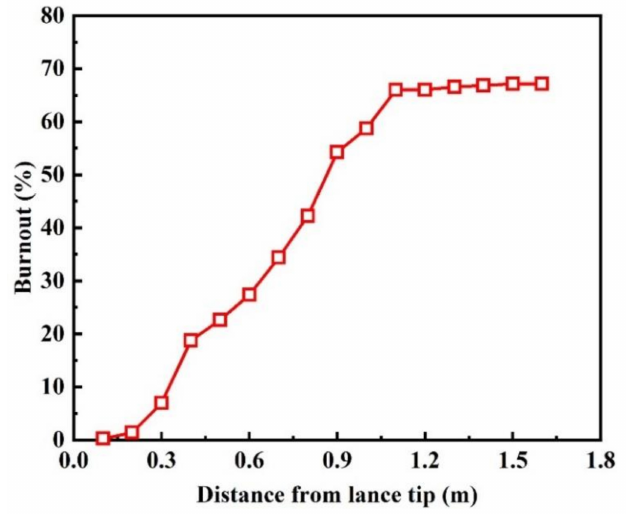
Figure 11. Evolution of pulverized coal burnout rate along the coal lance tip.